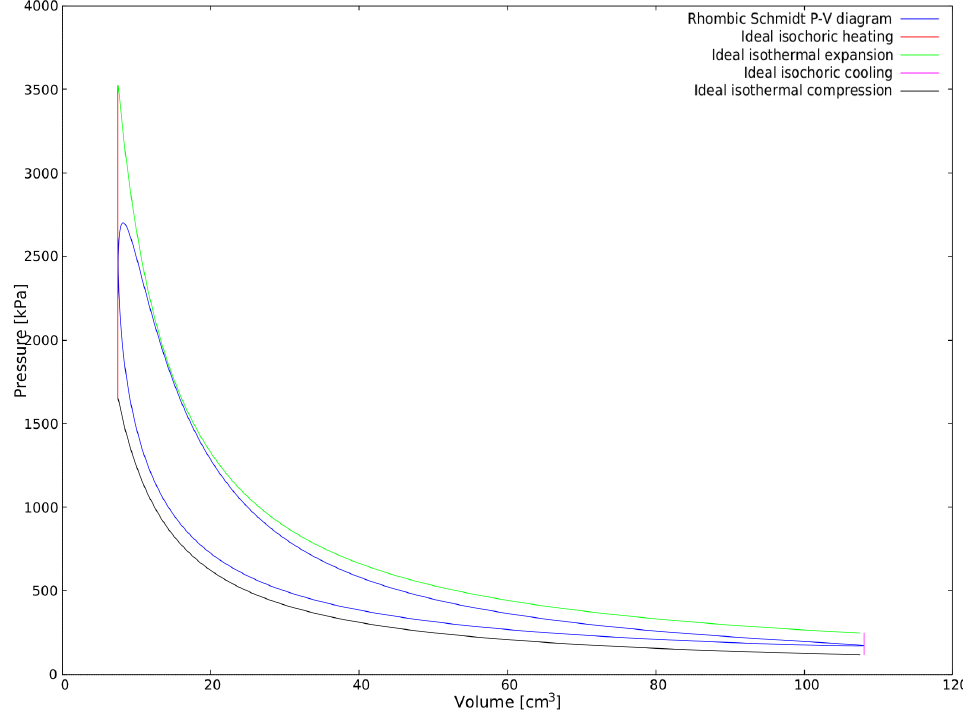
Figure 14. Alpha with Ross yoke P-V